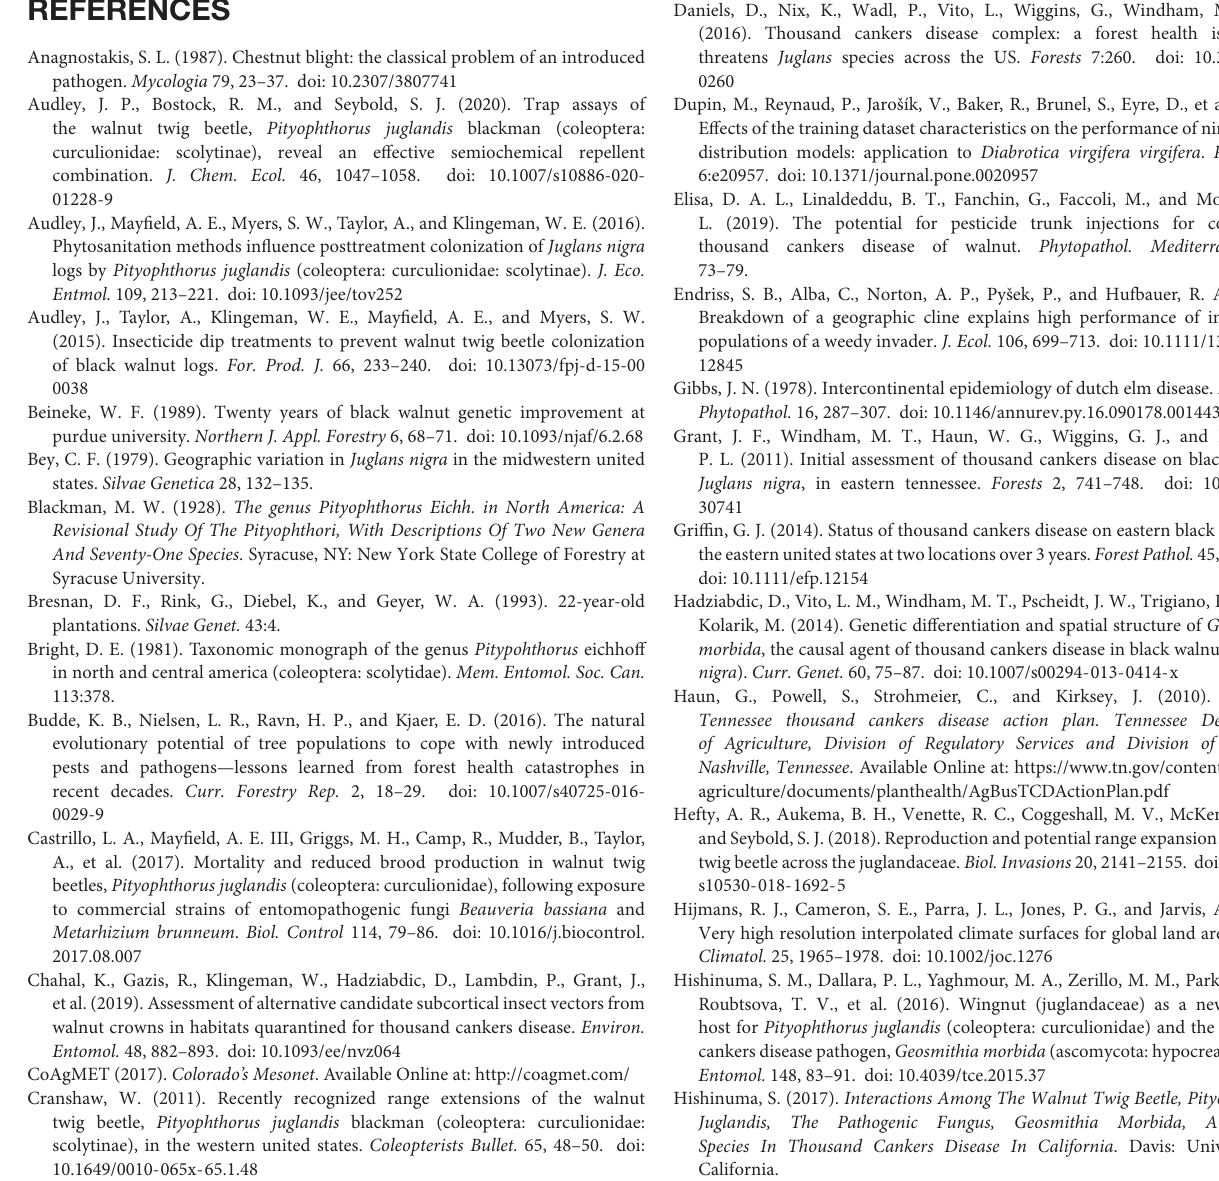
Supplementary Figure 1 | Inoculation of Geosmithia morbida caused cankers on Juglans nigra. Supplementary Figure 2 | Principal component biplot of bioclimatic variables to account for the climatic variation in the native range of Juglans nigra . The following 19 bioclimatic variables were obtained for each J. nigra seed source location. Linear components PC1: temperature accounted for 62.5% of the variation, PC2: precipitation in the warmest quarter accounted for 16.7% of the variation, and